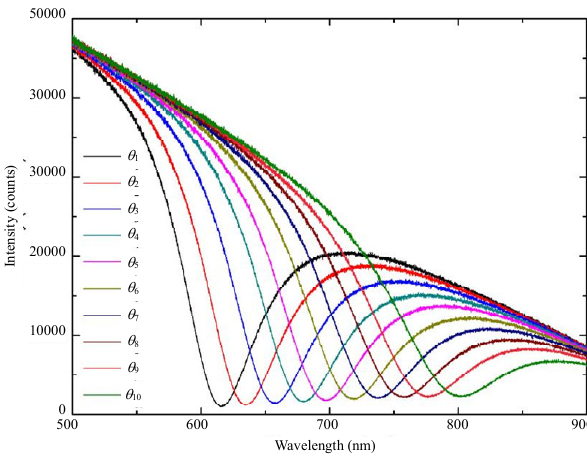
Fig. 6 SPR measurement curves affected by SPD3 (the reflectivity curves from left to right correspond to incident angles θ 1 , θ 2 , θ 3 , θ 4 , θ 5 , θ 6 , θ 7 , θ 8 , θ 9 , and θ 10 ,